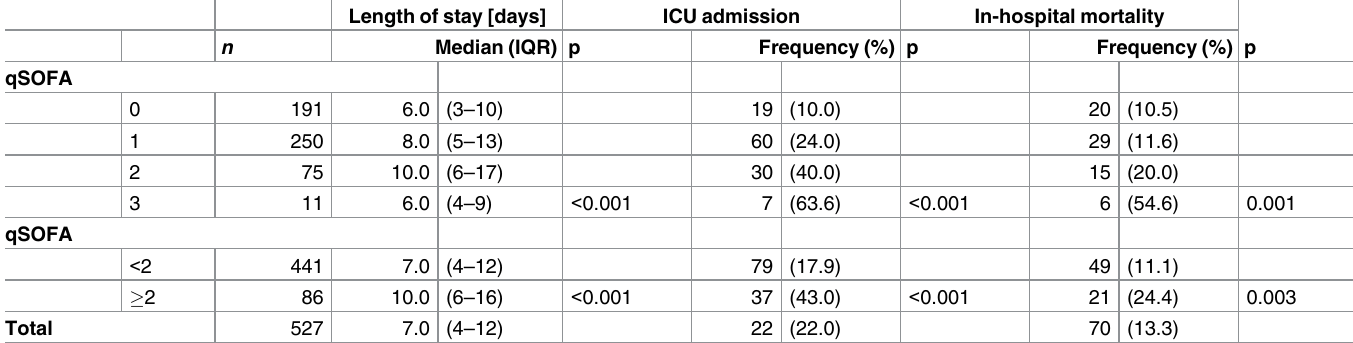
Table 3. Length of hospital stay, ICU admission and in-hospital mortality in patients with different qSOFA score categories in patients with pneu- monia (n =